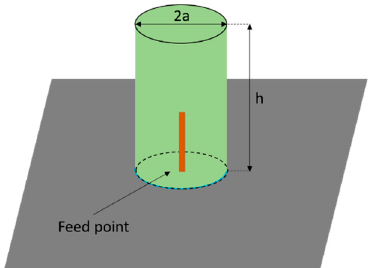
Figure 1. Three-dimensional (3D) view of the probe-fed cylindrical DRA.